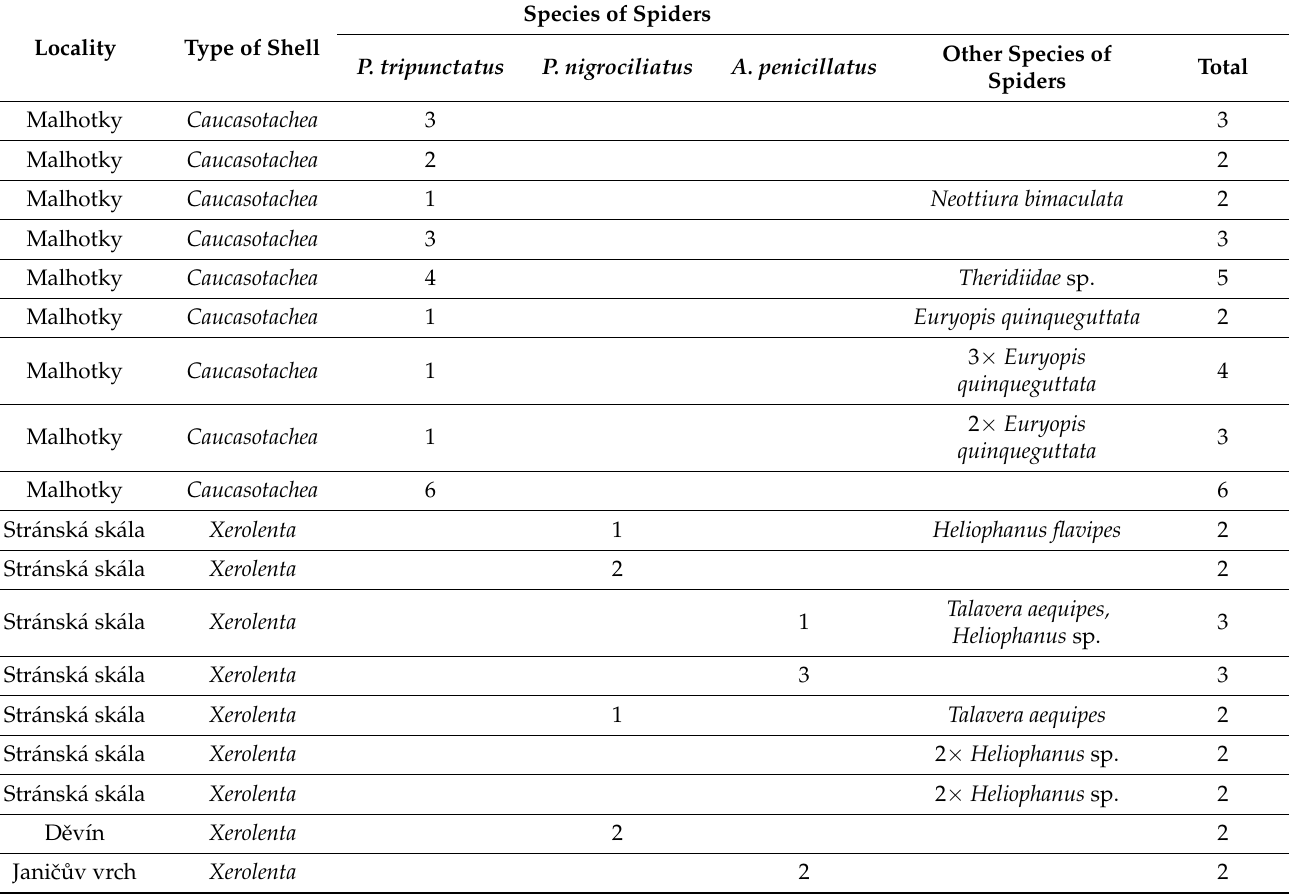
Table 5. Records of gregarious